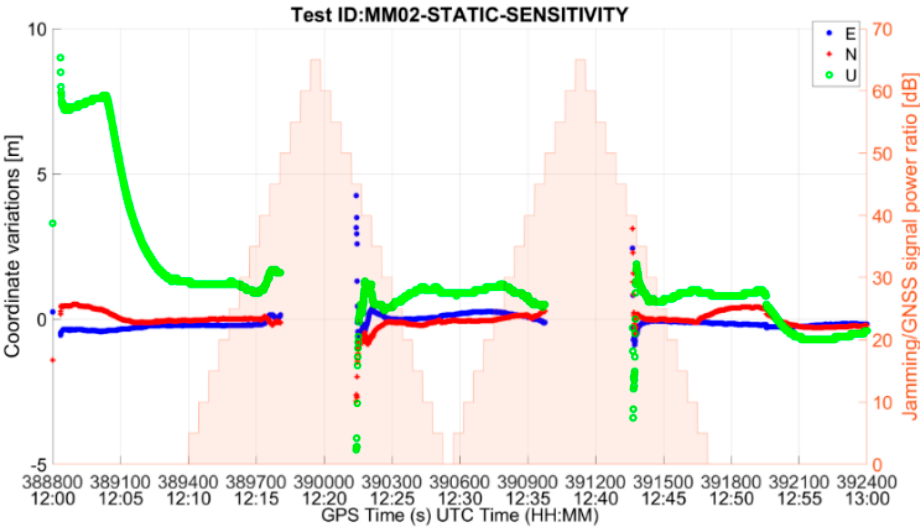
Figure 5. East-North-Up deviations for MM RUT in the presence of threat signature 02.